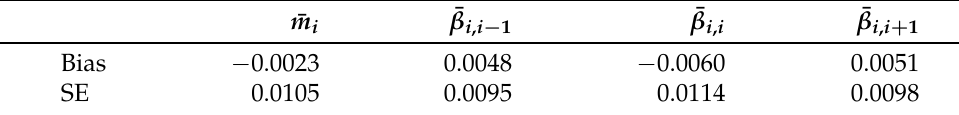
Table A1. Simulated estimates of the 2-LVAR